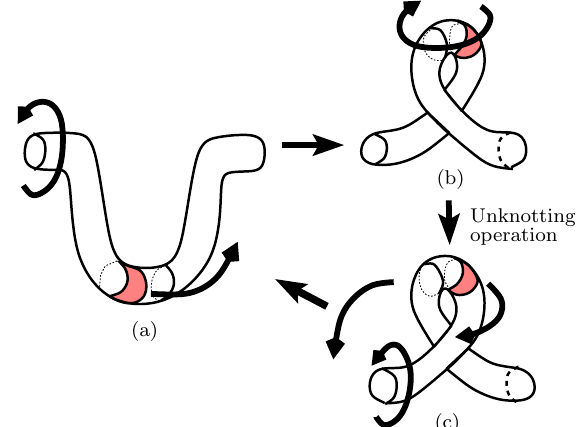
Fig. 7. (a) The U -shaped string is twisted around the axial curve. (b) A positive loop is created. (c) Applying unknotting operations to the crossing, the negative crossing is obtained.